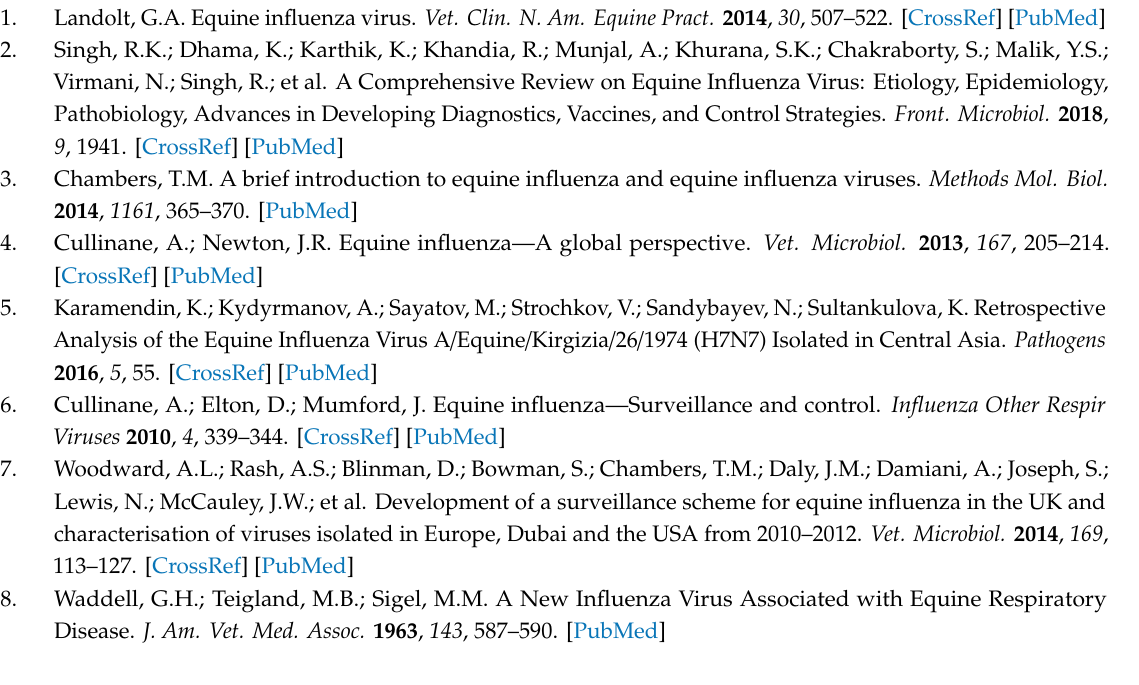
Figure S1: Nucleotide alignment of clade 1 Ohio / 03 and clade 2 Rich / 07 HA, Figure S2: Nucleotide alignment of clade 1 Ohio / 03 and clade 2 Rich / 07 NA and Figure S3: Correlation between HAI titer and Clinical